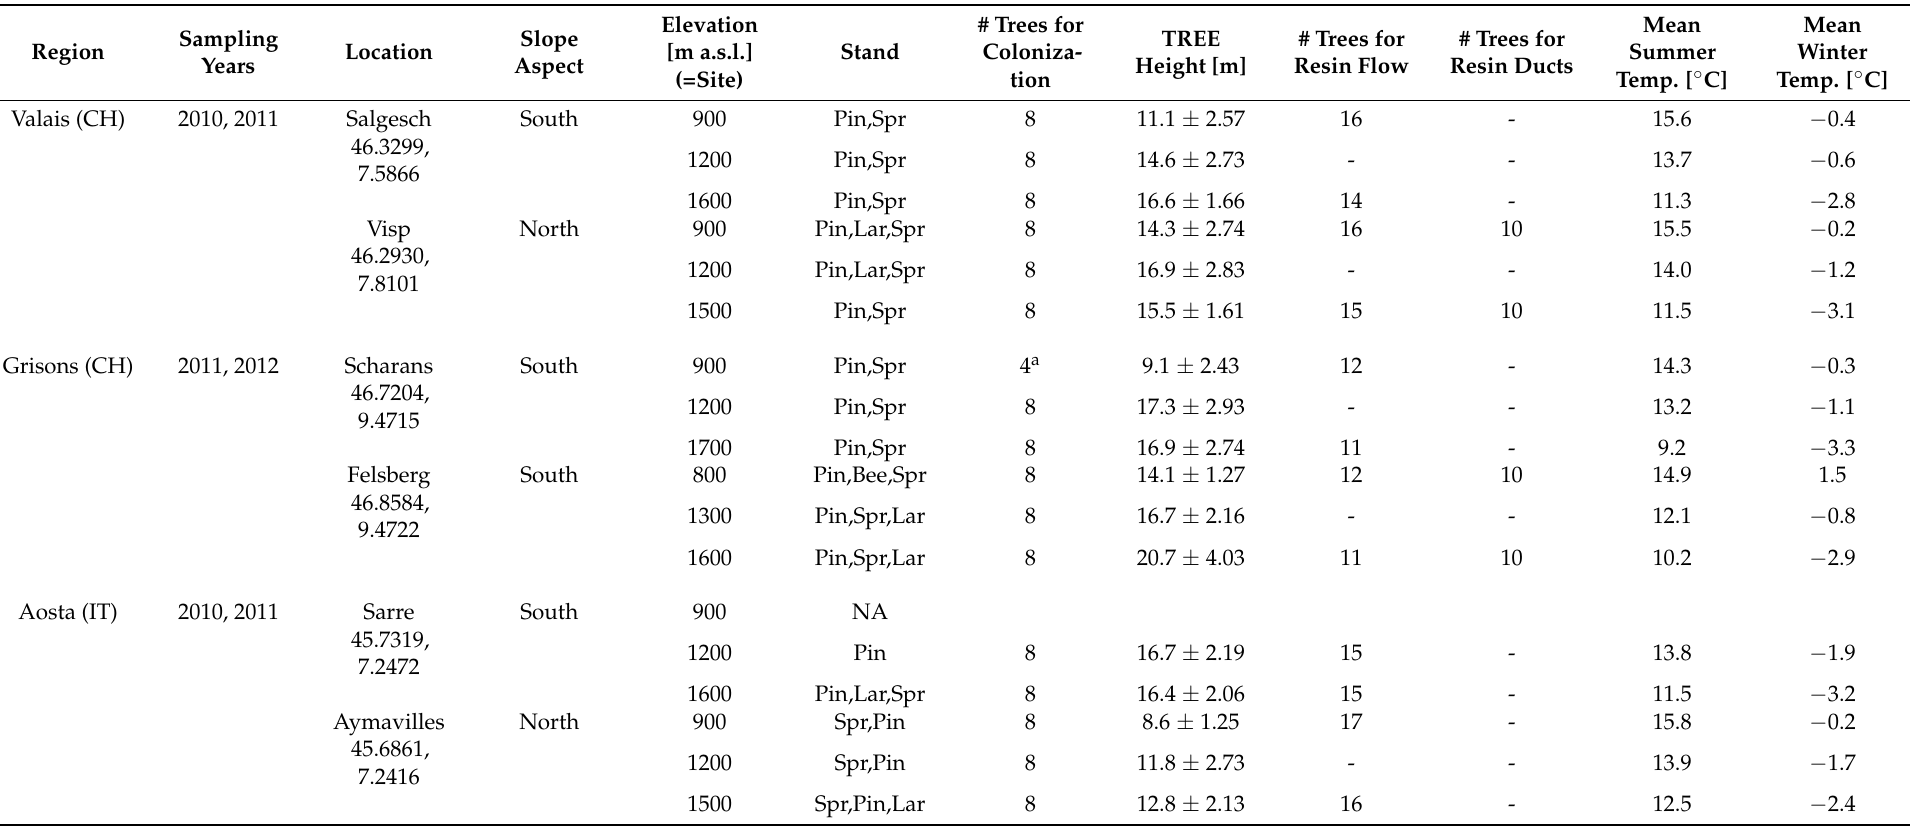
Table 1. Site characteristics and number of trees used to study insect colonization, resin flow, and resin ducts from three regions in Switzerland (CH) and Italy (IT). The WGS 84 coordinates refer to the site at the middle elevation level. (Pin = Scots pine, Spr = Norway spruce, Lar = European larch, Bee = European beech).